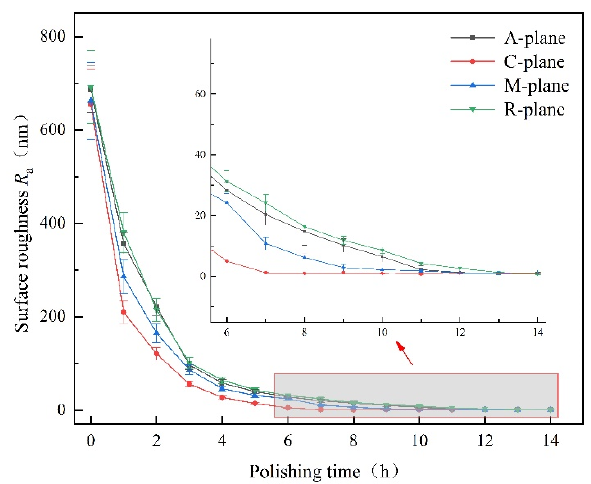
Figure 6. Surface roughness R a as a function of the polishing time of the four crystal orientations for the A-plane, C-plane, M-plane and R-plane.